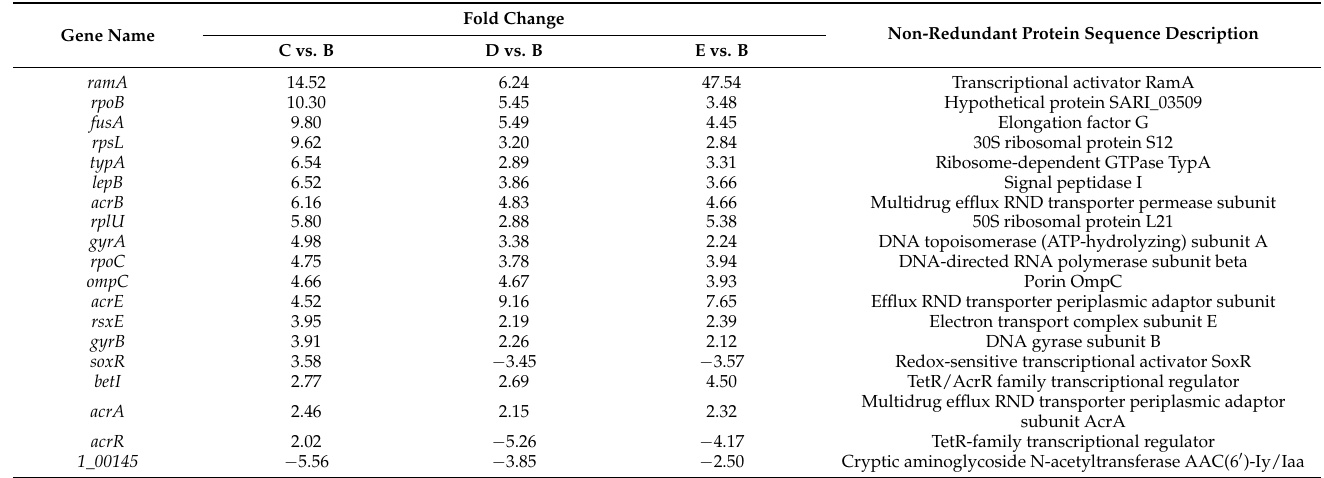
Table 3. Resistance-related DEGs blasted in the CARD.